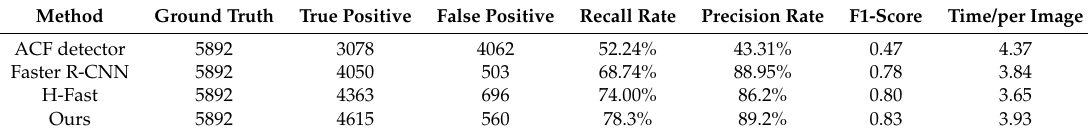
Table 4. Performance comparison between different